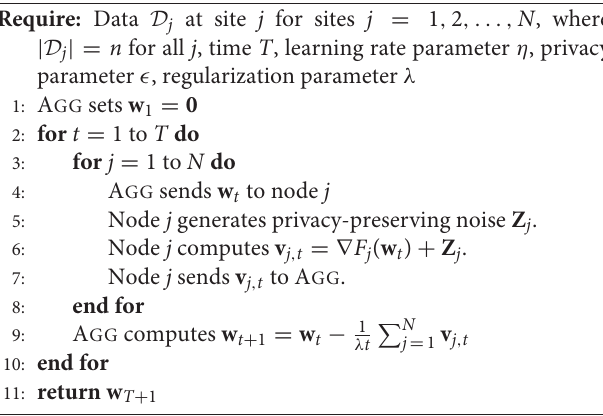
Algorithm 4 Differentially private stochastic gradient